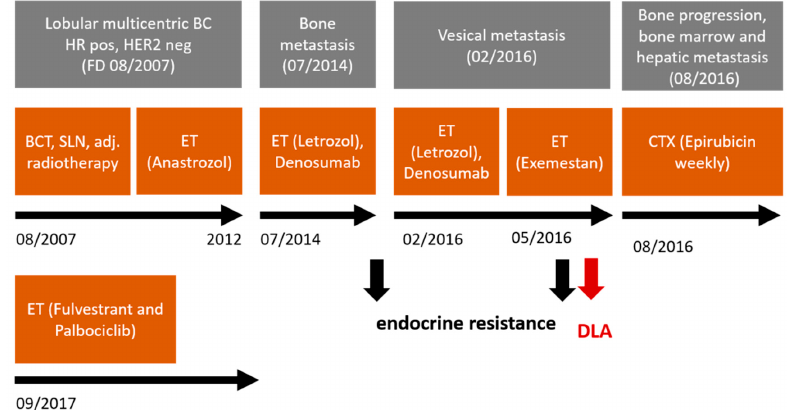
Figure 3 . Clinical characteristics and therapeutic interventions . The time-point of performed Diagnostic Leukapheresis (DLA) is depicted by the red arrow. The black arrows mark the appearance of therapeutic endocrine resistance.